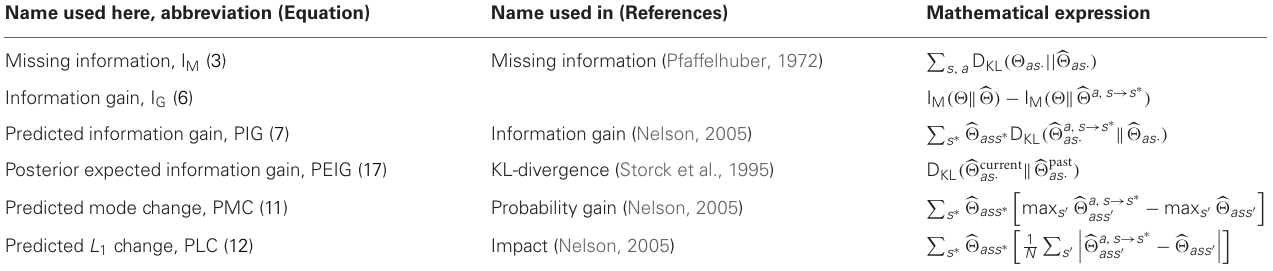
Table 1 | Table of measures. Name used here, abbreviation (Equation) Name used in